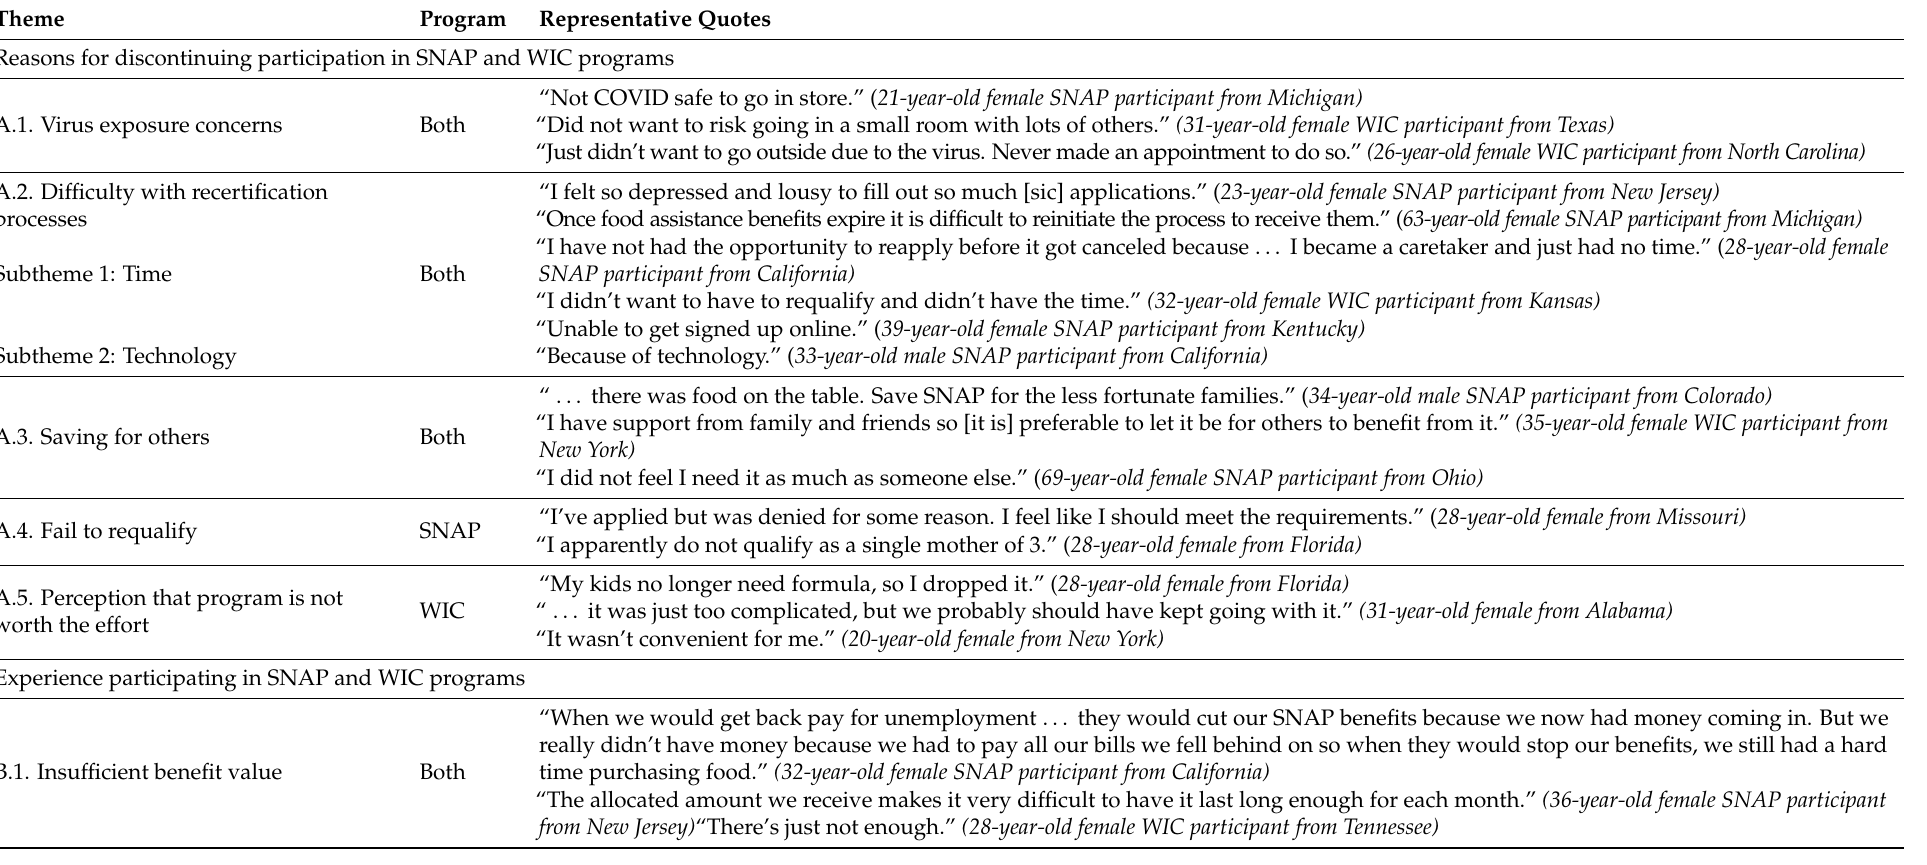
Table 2. Emergent Themes For (A) Reasons for Discontinuing Participation in the Supplemental Nutrition Assistance Program (SNAP) or the Special Supplemental Nutrition Program for Women, Infants, and Children (WIC) and (B) Experience Participating in SNAP or WIC Programs During the Coronavirus Disease 2019 (COVID-19)